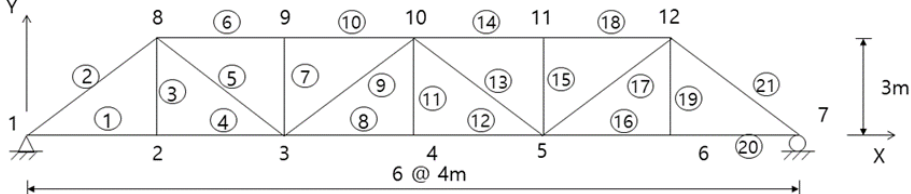
Figure 1. A simply supported truss structure for a numerical example. The circle numbers indicate the member number.